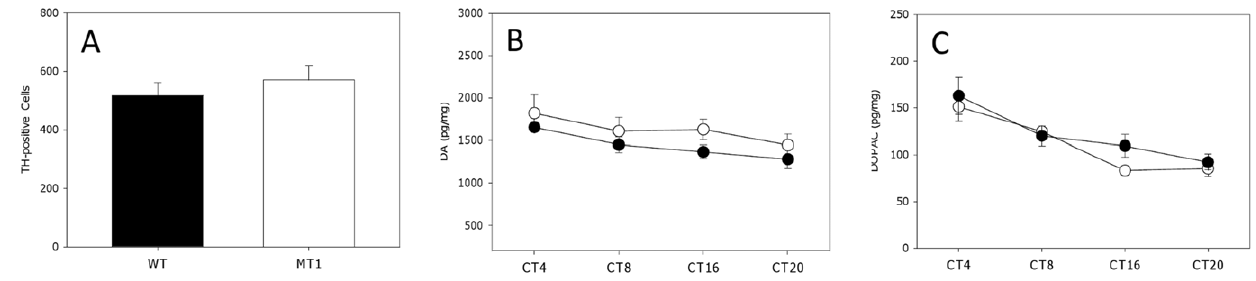
Figure 5. Number of TH-positive cells in the retina of WT and MT 1 2 / 2 (A) and DA and DOPAC levels measured in WT and MT 1 2 / 2 in DD. A) The number of TH-positive neurons in the retina of WT was not different from the number observed in MT 1 2 / 2 (t-test, P . 0.1). The level of DA (B) and DOPAC (C) decreased as expected from day to night in both genotypes (WT: white circles; MT1 2 / 2 : black circles), and no differences were observed in mean levels of DA and DOPAC at each time-point between the WT and MT 1 2 / 2 (Two-way ANOVA, P , 0.05 in both cases). N=9–12 for each point and genotypes.